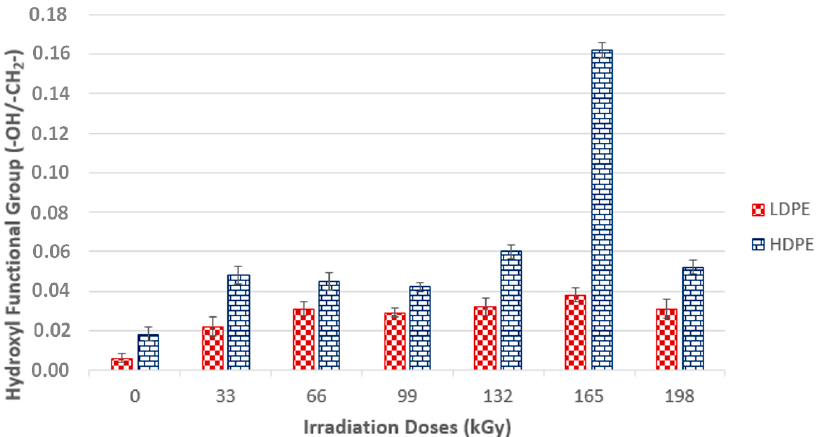
Figure 14. Relative number of hydroxyl functional groups and radiation dose relationships; the vertical line drawn at the top of the column represents the standard deviation.